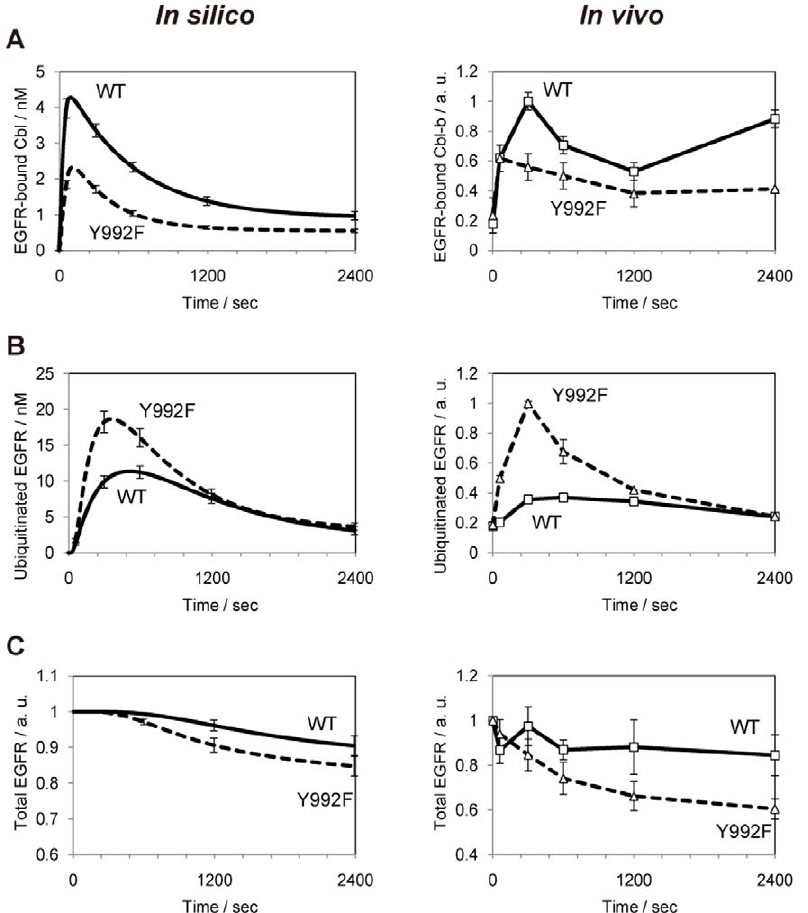
Figure 7. Comparison of in silico (left) with in vivo (right) dynamics of EGFR degradation pathway. A, B . The temporal dynamics of EGFR-bound Cbl-b and ubiquitinated EGFR. Extracted proteins were normalized to the initial expression amount of EGFR, and then subjected to EGFR immunoprecipitation. Immunoblottings were performed to detect co-immunoprecipitated Cbl-b and ubiquitinated EGFR. Error bars represent the deviations of two independent experiments. The simulated results were normalized to the initial abundance of EGFR predicted in silico. C .